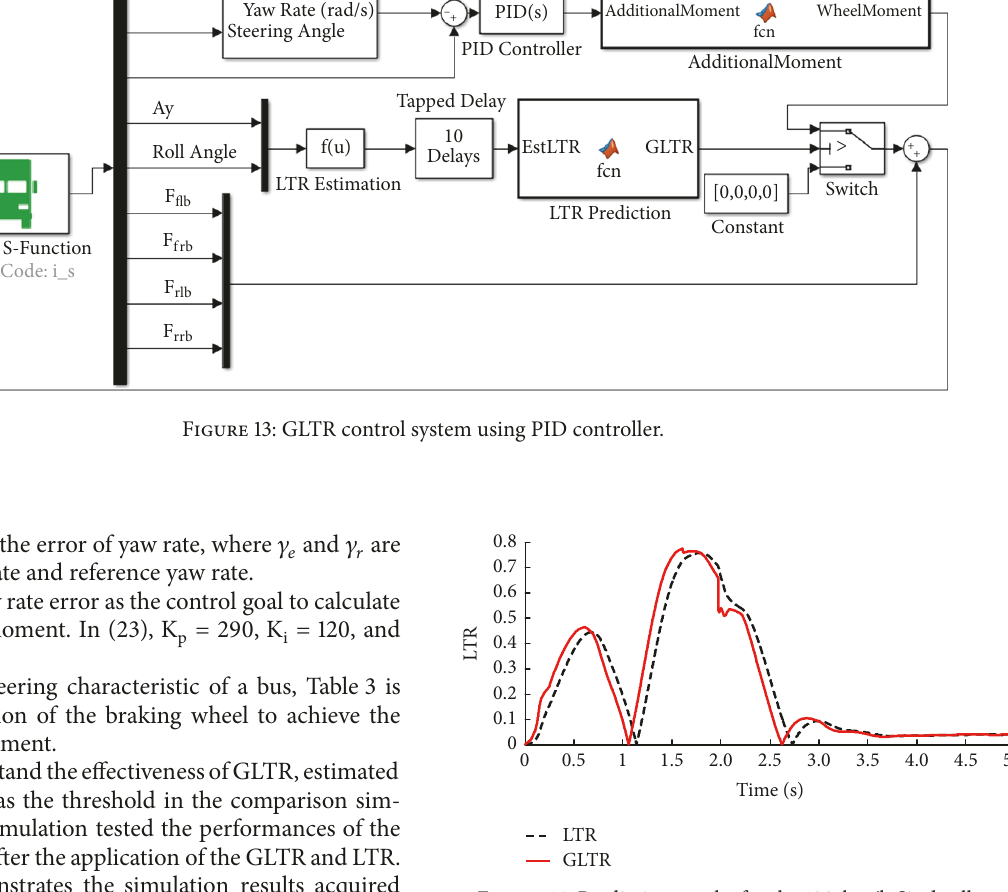
Figure 14: Prediction results for the 100-km/h Sindwell test.